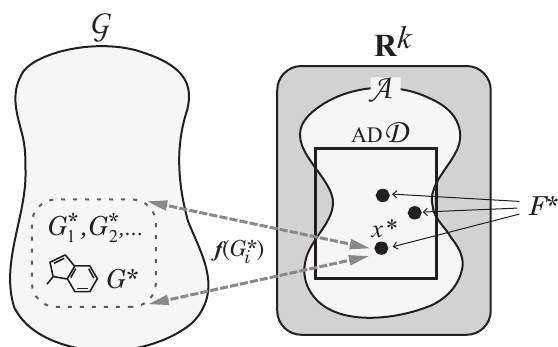
Figure 7. An illustration of Step 5: For each vector x ∗ ∈ F ∗ , all chemical graphs G ∗ ∈ G such that f ( G ∗ ) = x ∗ are